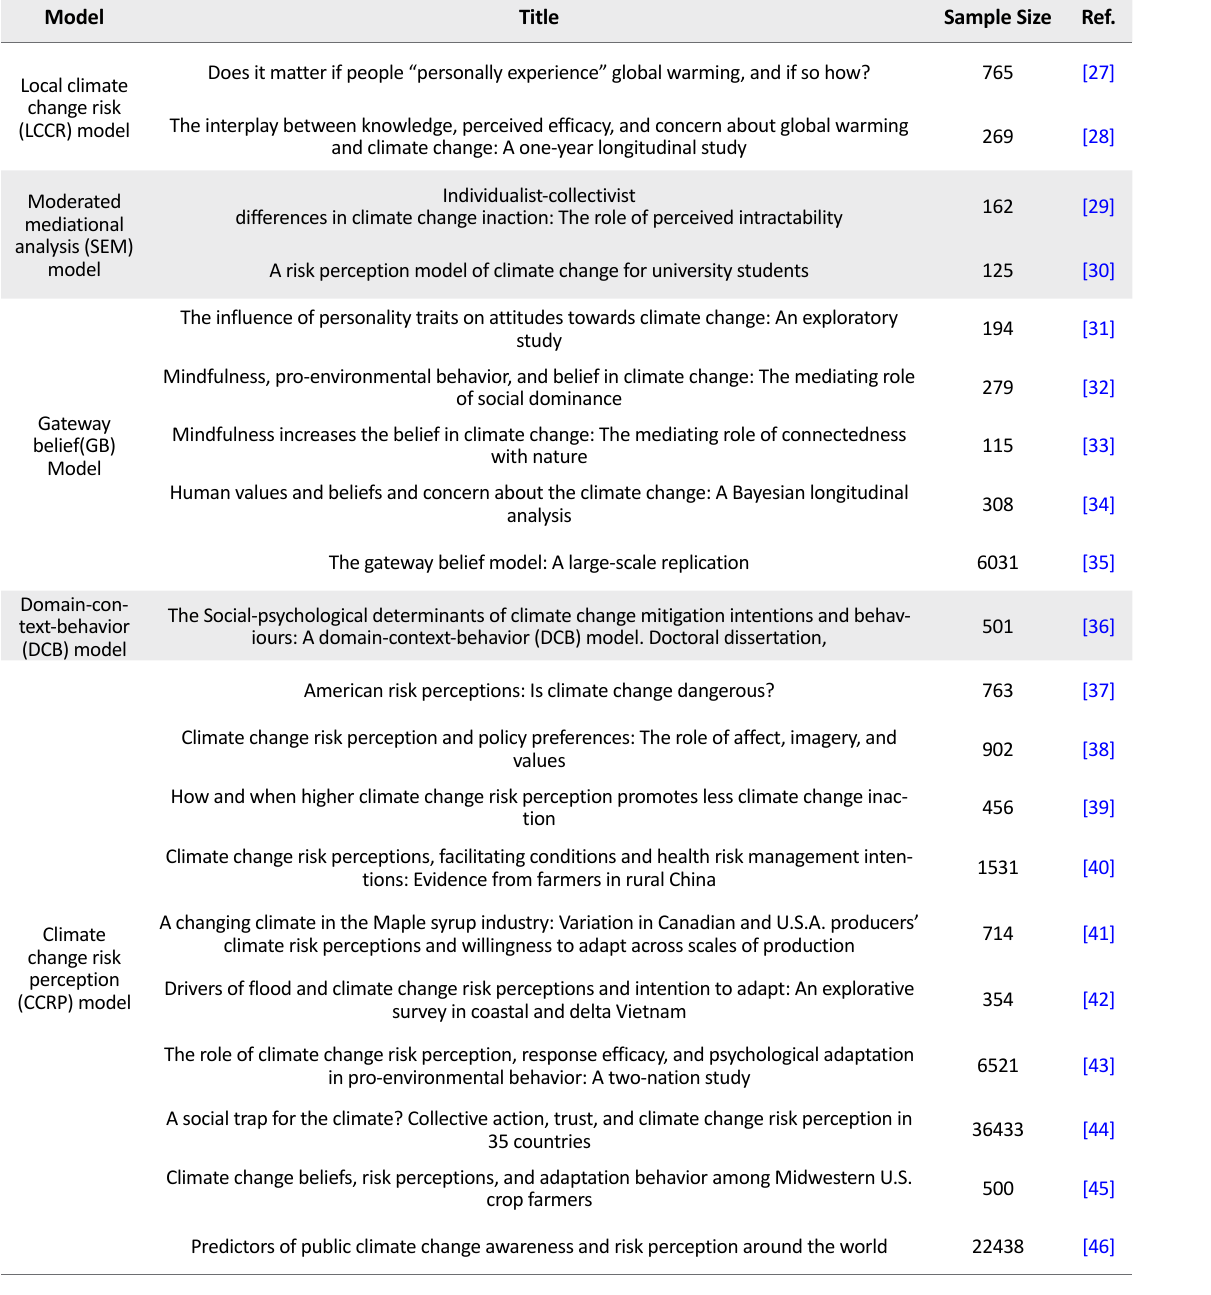
Table 1. Overview and classification of studies extracted from the systematic literature research